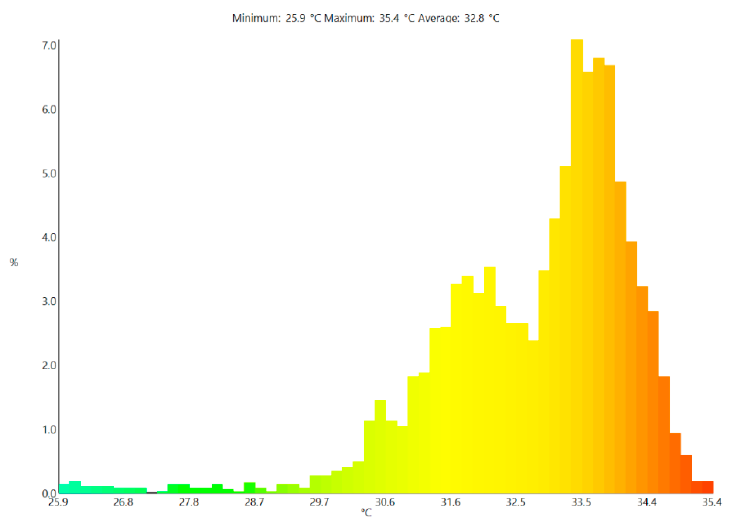
Figure 10. Thermal image of a cooled PV panel.